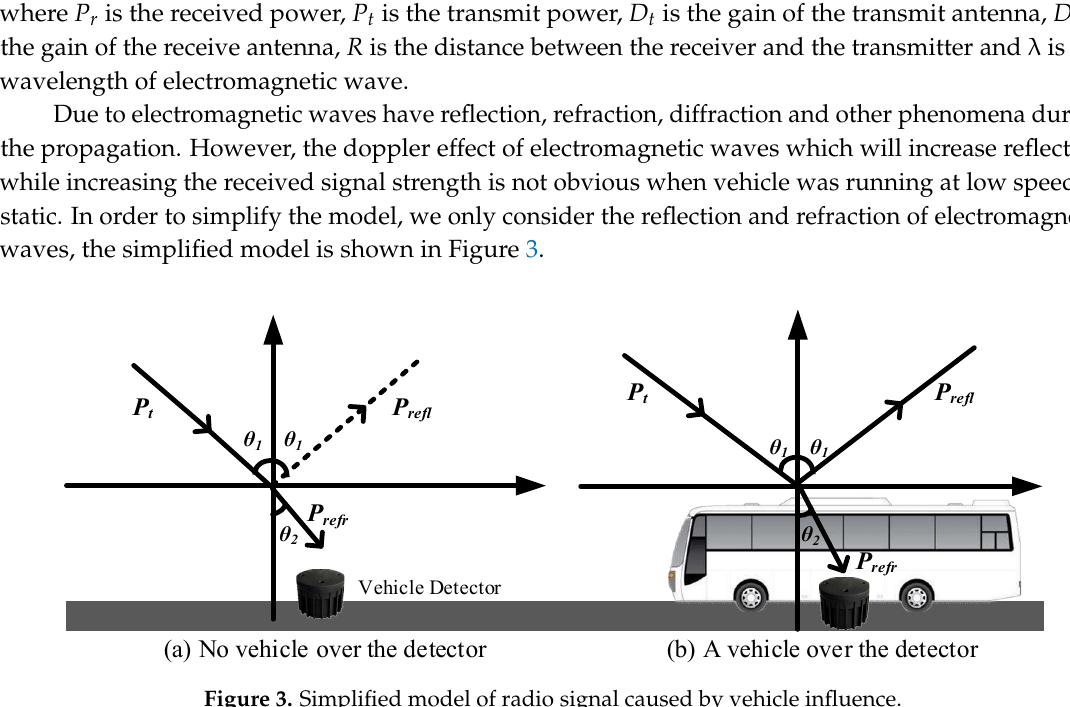
Figure 3. Simplified model of radio signal caused by vehicle influence.